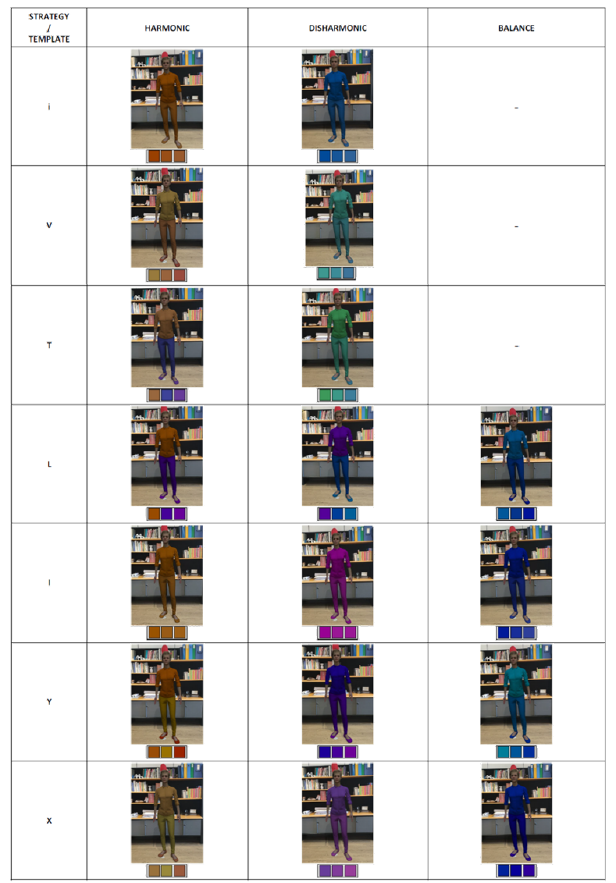
Figure 9. Recolored human avatar by applying all templates and the three strategies. The disharmonic approach, instead, produces colors that ensure a high contrast with the real one. When I and X templates are selected, the clothes of a human avatar are recolored with shades of violet. In the cases of V and T templates, shades of green are proposed. The application of L and Y templates generated colors represented by shades of blue and violet. Finally, the template i produces shades of blue. The balance approach generates shades of blue in the case of L, I, and X templates, while shades of light